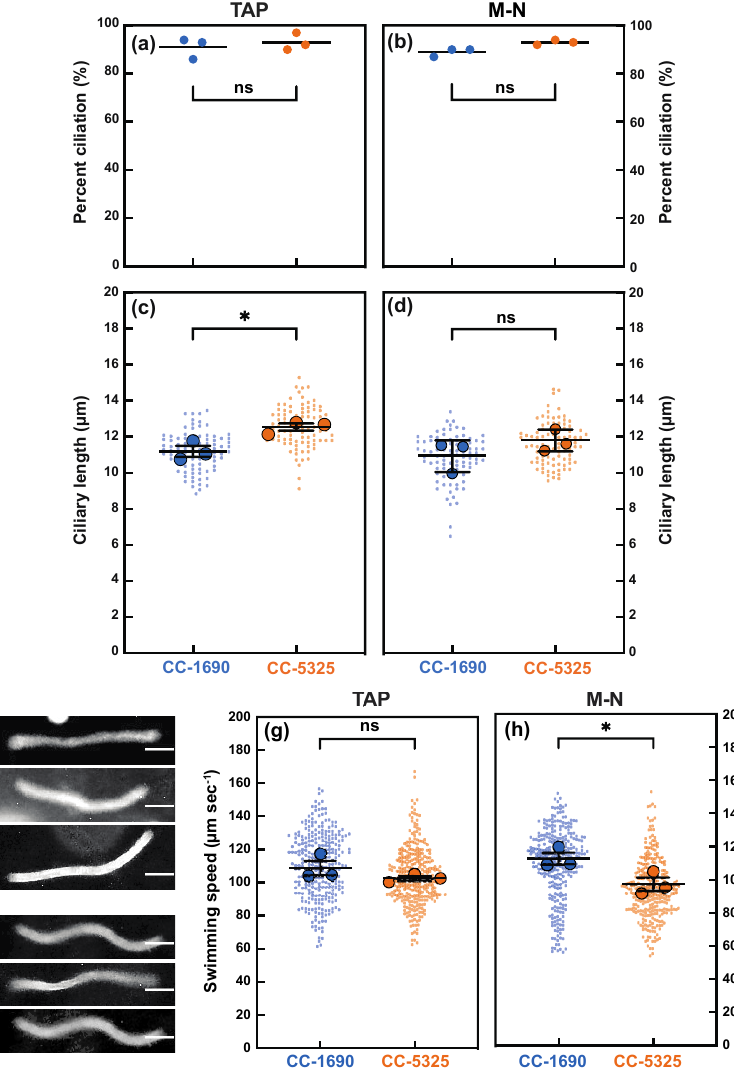
Figure 10. In comparison to CC-1690, CC-5325 had longer cilia in tris-acetate-phosphate (TAP) medium but slower swimming speed in M-N medium (minimal medium without nitrogen and acetate). CC-1690 and CC-5325 cells were grown in TAP ( a , c , g ) or in M-N ( b , d , h ) with constant agitation and under constant light of 100 μ mol photons m − 2 s − 1 . ( a , b ) The percentage of cells with cilia was counted. The center (horizontal lines) represents the mean of 3 biological replicates where N = 100 in each replicate. The three dots represent the mean of each biological replicate. Significance was determined by Chi-square analysis, p = 0.4521 for ( a ), p = 0.1159 for ( b ); ns, not significant. ( c , d ) Ciliary length was measured using ImageJ. Superplots were created by measuring the mean (the larger dots) of 3 biological replicates. Data points from individual cells are shown as small dots. The center (longer horizontal bars) represents the mean of the 3 biological replicates (N = 30 in each replicate), and the shorter horizontal bars represent standard error. Significance was determined by using a two-tailed t -test assuming unequal variance, ( c ) * means significance, p = 0.0265 and ( d ) p =